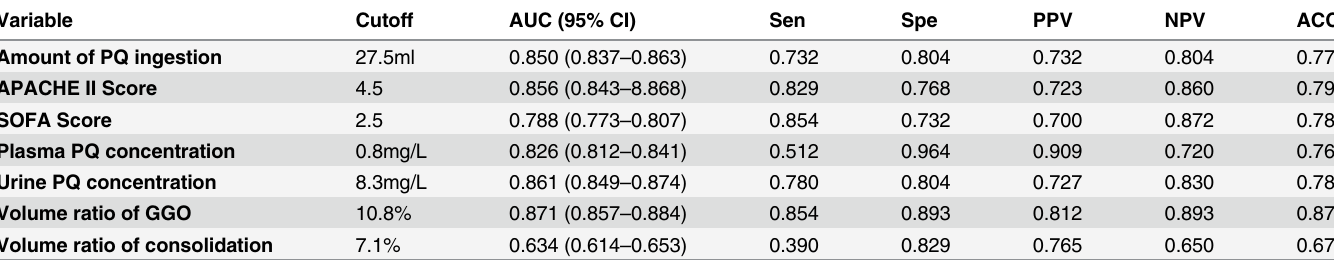
Table 3. Comparison of Predictors for Mortality of PQ Poisoning.